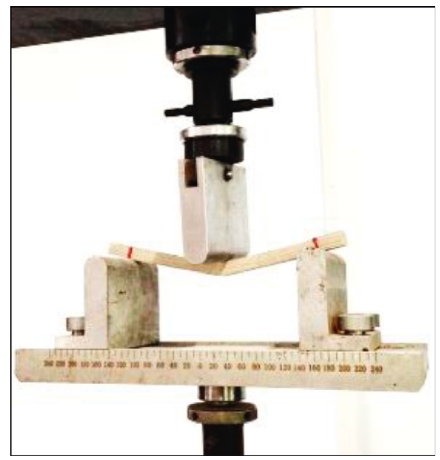
Figure 2: Flexural test setup.